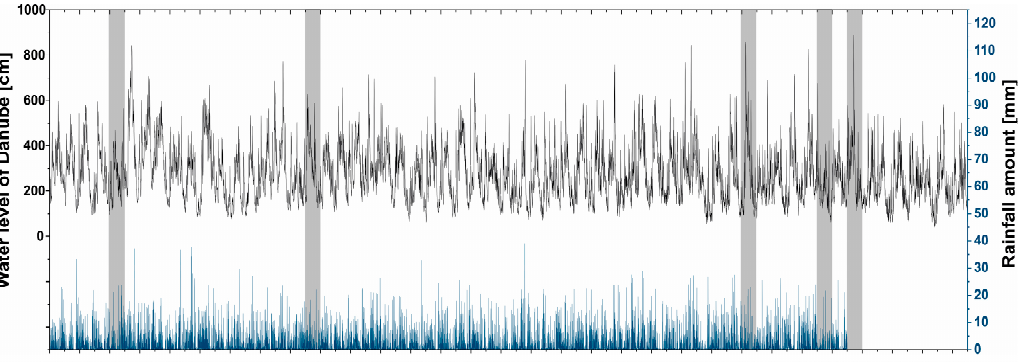
Figure 2. The data used during the statistical analyses. The blue line is daily precipitation, and the black, the daily water level of the Danube. Grey areas are years of landslide.